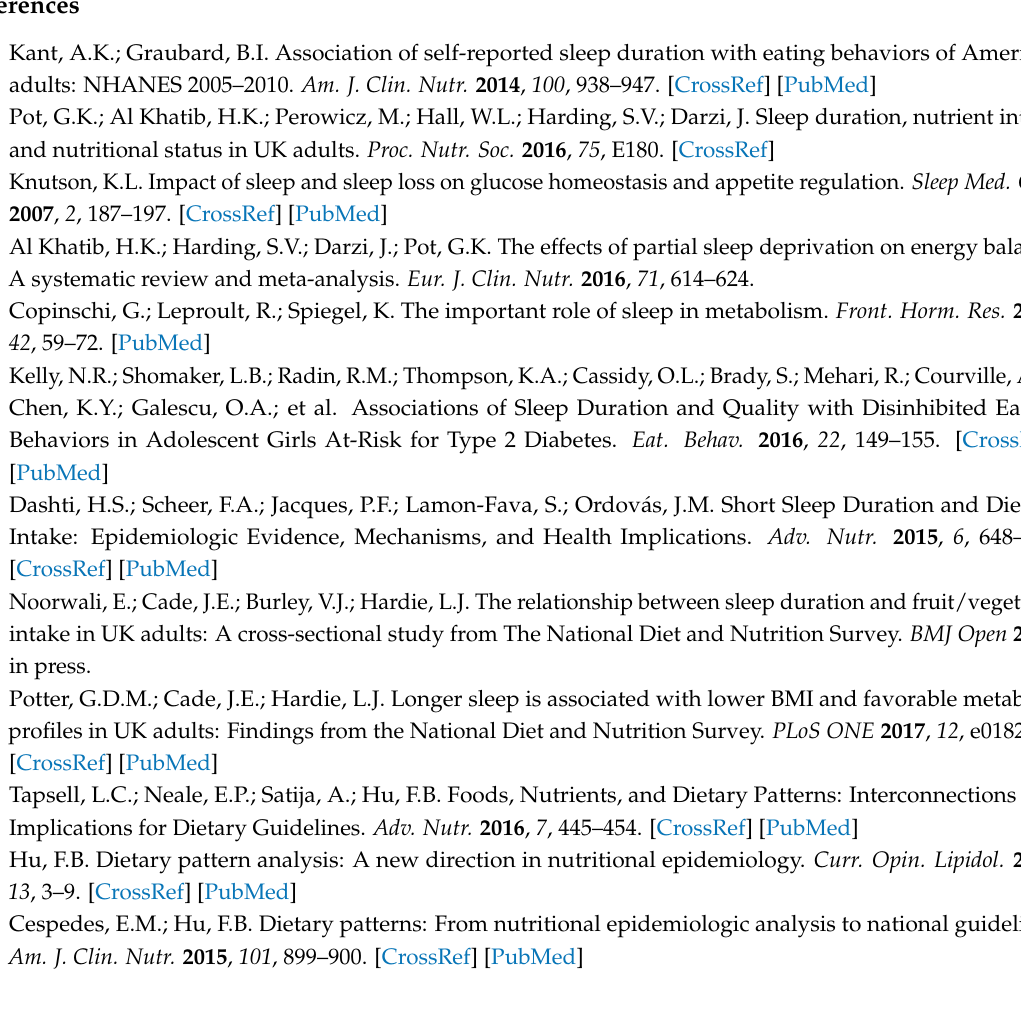
Table S1: Coefficient estimates from the regression model of the association between sleep duration on weekdays or sleep lag and the healthy dietary pattern including mental illness as a covariate. Variables with p ≤ 0.01 were deemed to be significant, Table S2: Coefficient estimates from the regression model of the association between sleep duration on weekdays and the healthy dietary pattern excluding sleep on weekends as a covariate. Variables with p ≤ 0.01 were deemed to be significant, Table S3: Coefficient estimates from the regression model of the association between sleep duration on weekdays and the healthy dietary pattern. Lower tertiles defined using ≤ 6 h as cut-off and upper tertile defined using ≥ 9 h as cut-off. Variables with p ≤ 0.01 were deemed to be